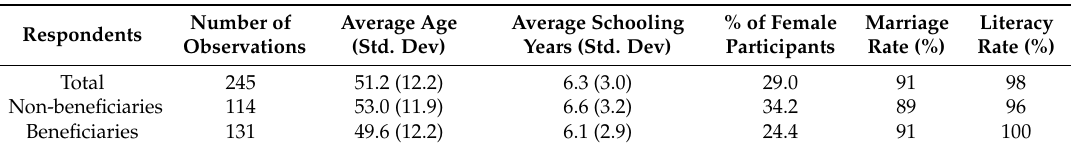
Table 1. Descriptive statistics of the respondents’ demographic information for non-beneficiaries and beneficiaries.